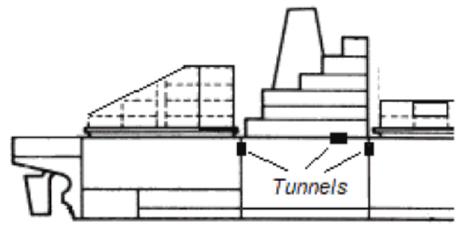
Figure 3. Wireless communication